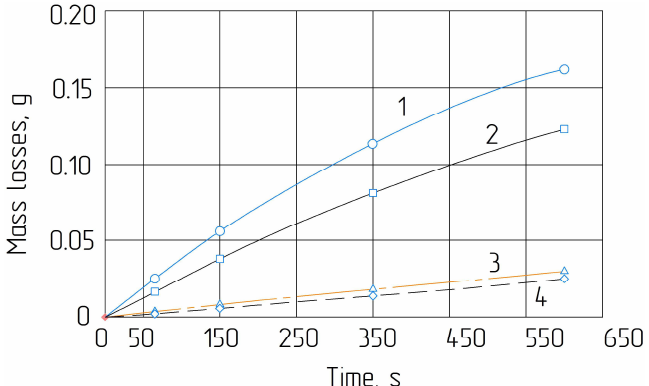
Figure 9. The dependence of mass losses for steel DIN C80W1 with wear-resistant coatings on time under sliding friction conditions without lubrication (force—40 N, velocity—4 m/s): 1—without treatment; 2—nitriding; 3—chroming; 4—nitrogenchroming.